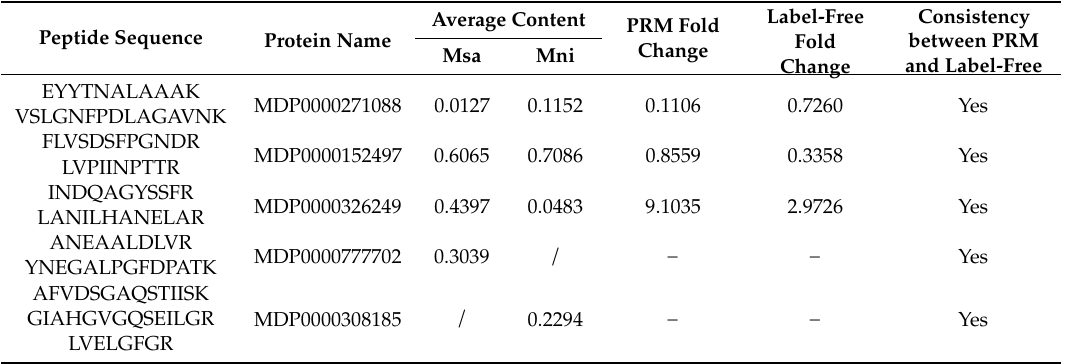
Table 2. Quantitative results for five candidate proteins determined using the parallel reaction monitoring (PRM)